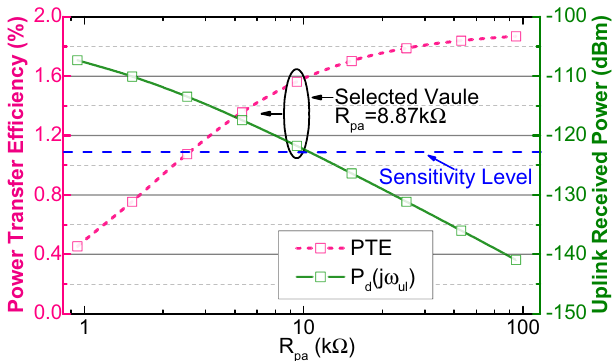
Figure 7. Calculated PTE and received uplink signal power versus R pa , when k = 0.01.